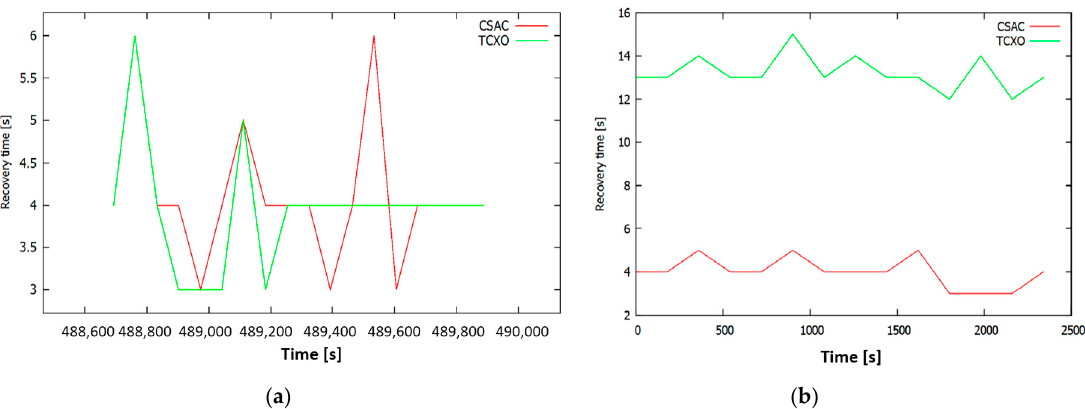
Figure 12. CSAC and TCXO holdover of: 10 s ( a ); and 120 s ( b ).